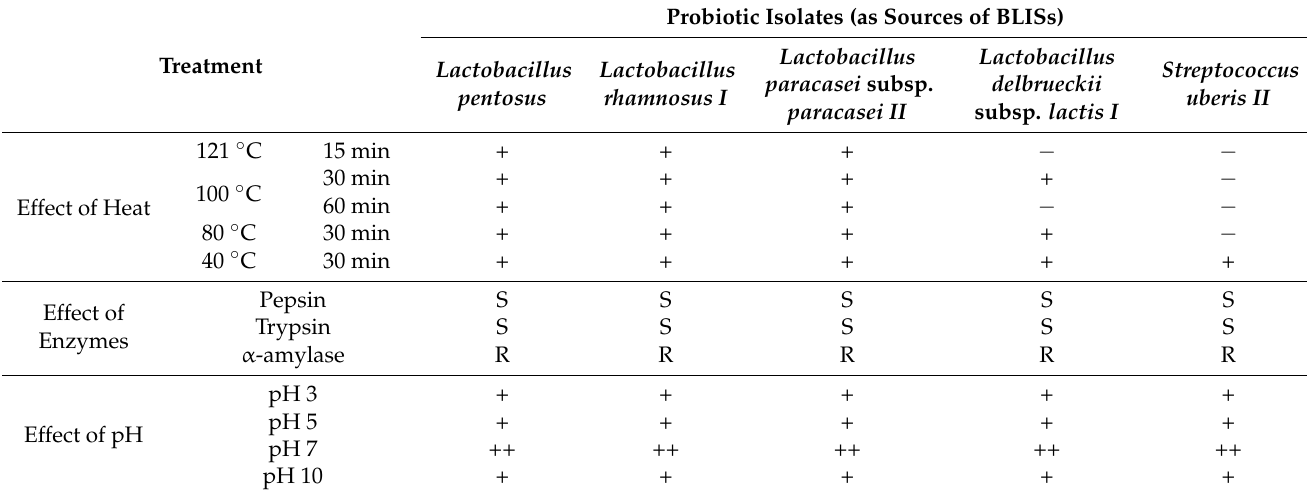
Table 2. Effect of heat, enzymes, and pH on bacteriocin-like inhibitory substances (BLISs).